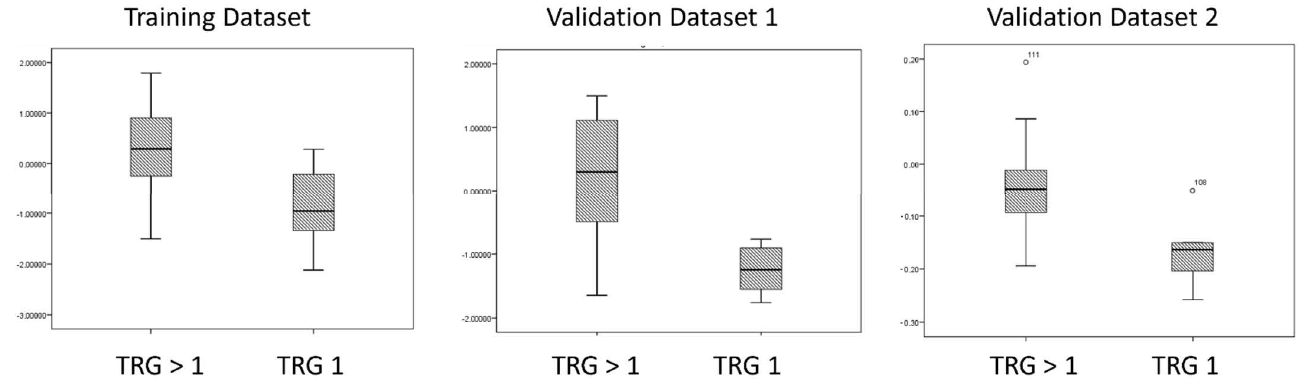
Figure 1. Box plot of the D-TA ADC GLCM Entropy in the training dataset ( left ) and validation datasets ( right ).